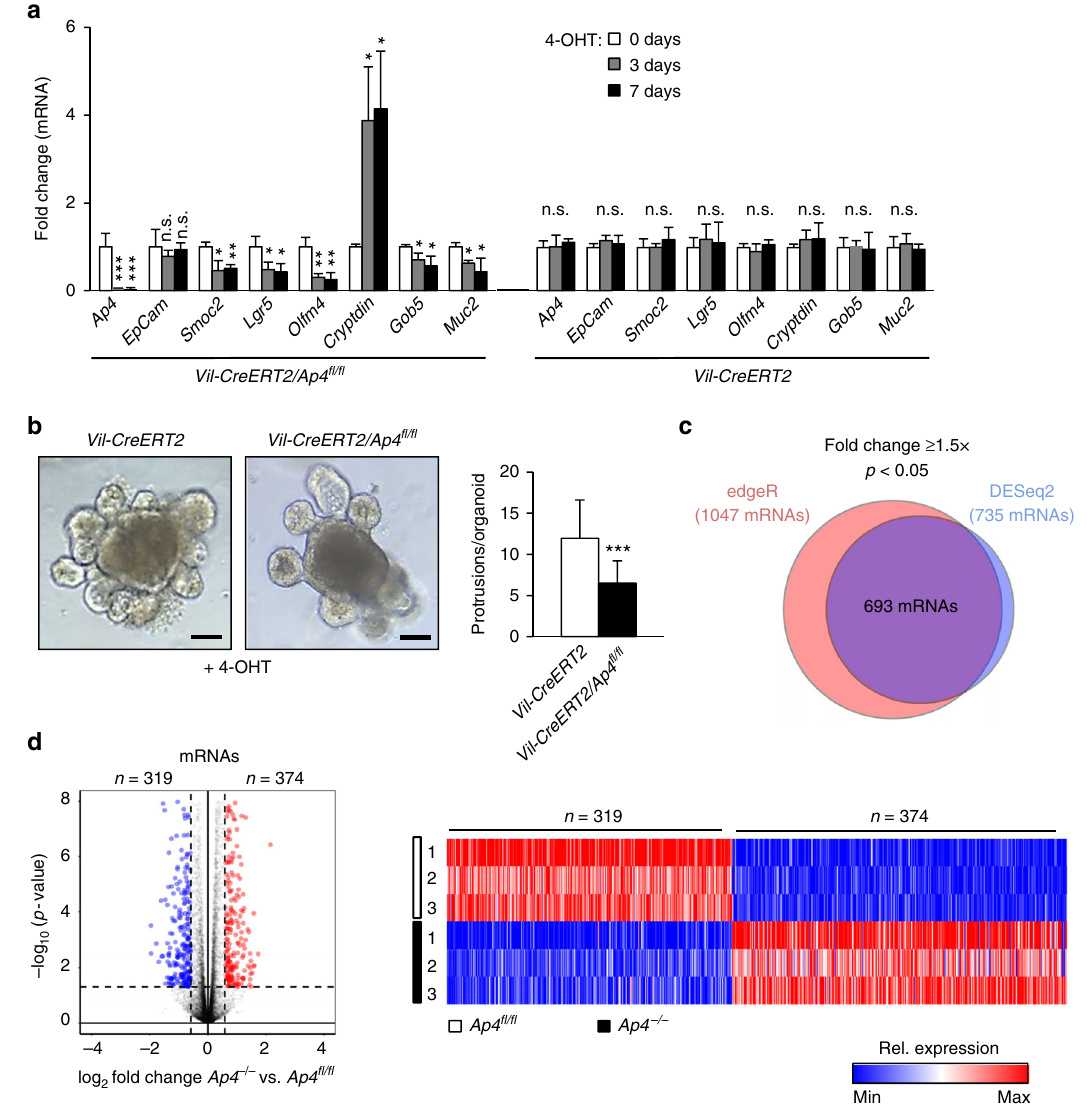
Fig. 7 Effects of Ap4 deletion on intestinal organoids. a qPCR analysis of the indicated mRNA from organoids isolated from three female mice per genotype after passaging and 7 days after Cre activation by 4-OHT. b Left panel: representative pictures of small intestinal organoids 7 days after passaging and Cre activation by 4-OHT. Scale bars represent 20 µ m. Right panel: quanti fi cation of protrusions (crypt-like structures) per organoid derived from three female mice per genotype. A total of 81 organoids were evaluated per genotype. c Venn diagram displaying differentially regulated mRNAs (fold change ≥ 1.5, p < 0.05) in Ap4 fl / fl and Ap4 Δ IEC organoids as determined by edgeR and DESeq2. d Volcano plot and heatmap depicting expression changes of differentially expressed mRNAs between Vil-Cre-ERT2 and Vil-Cre-ERT2/Ap4 fl / fl organoids, 7 days after Cre activation by 4-OHT, detected by RNA-Seq. Left panel: volcano plot depicting expression changes of differentially expressed mRNAs (fold change ≥ 1.5) from Ap4 fl / fl and Ap4 Δ IEC organoids. Downregulated mRNAs are depicted in blue, upregulated mRNAs are depicted in red. RNAs with fold changes < 1.5 and/or statistically nonsigni fi cant changes in expression are indicated in black. Dashed vertical lines indicate 1.5-fold change cutoff. Dashed horizontal line indicates the cutoff for adjusted p -values < 0.05 as determined with DESeq2. Right panel: Heatmap depicting expression changes of differentially expressed mRNAs (fold change ≥ 1.5 p < 0.05 as determined by edgeR and DESeq2 ) from Ap4 fl / fl and Ap4 Δ IEC organoids. Colors indicate relative expression values from minimum (blue) to maximum (red) for each RNA sample per differentially regulated mRNA. a , b Results represent the mean ± SD. Results were subjected to an unpaired, two-tailed Student ’ s t -test with p -values * < 0.05, ** < 0.01, *** < 0.001, n.s.: not signi fi